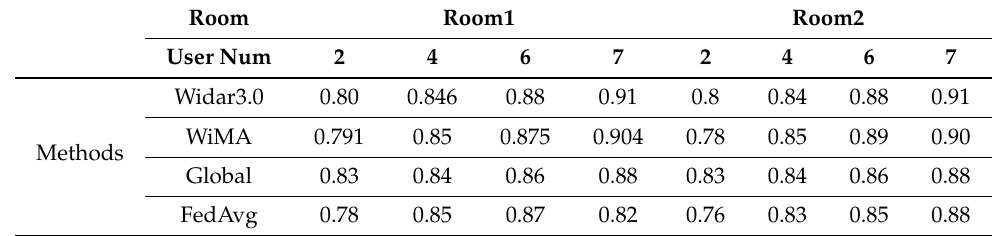
Table 1. Comparison of the accuracy of various methods with the number of users in different rooms. Room